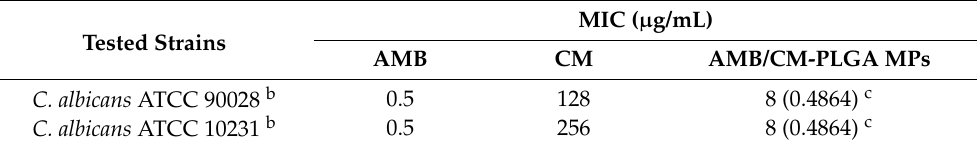
Table 2. Minimum inhibitory concentrations (MICs) of AMB, CM, and AMB/CM-PLGA MPs